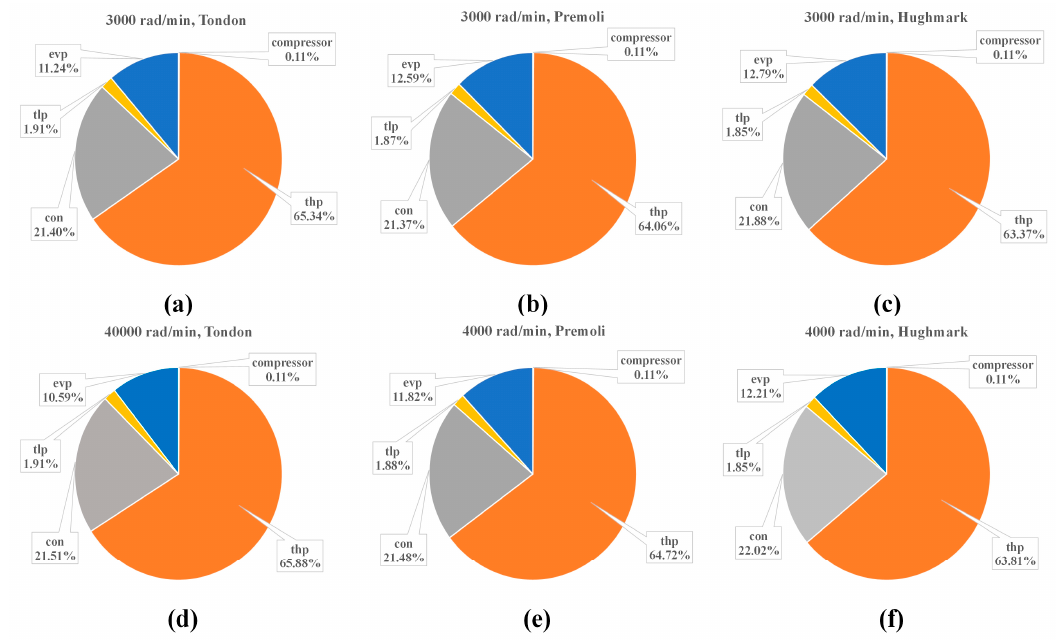
Figure 11. The proportion of each part of charge amount theoretical calculation in cooling mode. With different refrigerant charge quantity calculation models under different compressor speeds: ( a ) with Tandon model under 3000 r/min; ( b ) with Prelimi model under 3000 r/min; ( c ) with Hughmark model under 3000 r/min; ( d ) with Tandon model under 4000 r/min; ( e ) with Prelimi model under 4000 r/min; ( f ) with Hughmark model under 4000 r/min.